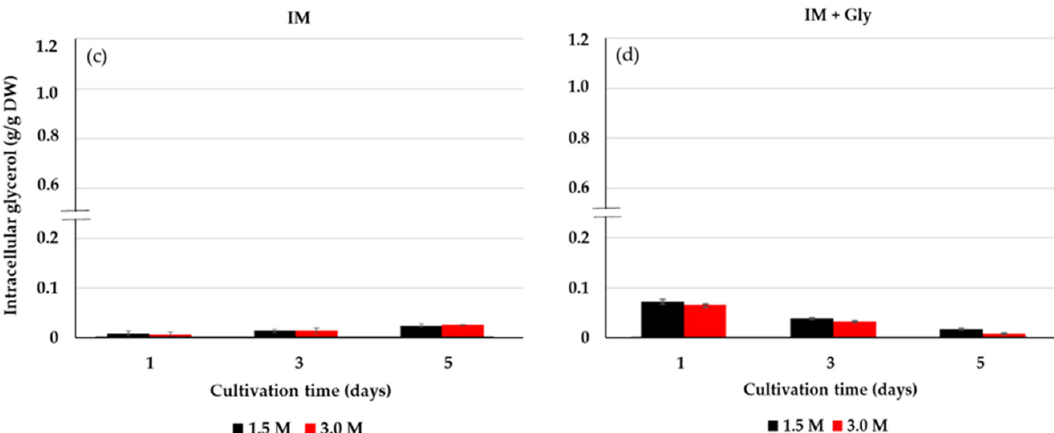
Metabolites 2021 , 11 , × FOR PEER REVIEW Figure 5. Extracellular glycerol from IM ( a ) and IM + Gly ( b ) and intracellular glycerol from IM ( c ) and IM + Gly ( d ) in D . salina cultivated on 12.5 mM glycerol. Salinities: 1.5 and 3.0 M NaCl. Intracellular glycerol concentrations were normalized to dry cell weight (DW). Values correspond to the mean ± standard deviation of three replicates.